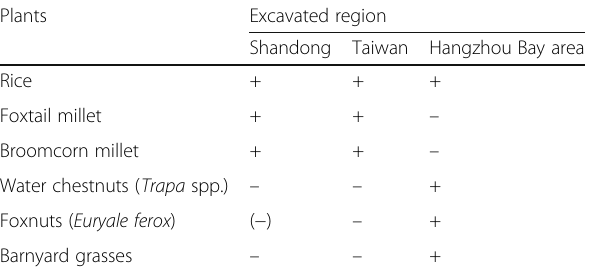
Table 4 The principal plant foods in three Neolithic regions on the China coast. Three domesticated plants (rice, foxtail millet, broomcorn millet) and three non-domesticated ones (water chestnuts, foxnuts, barnyard grasses) are listed Plants Excavated